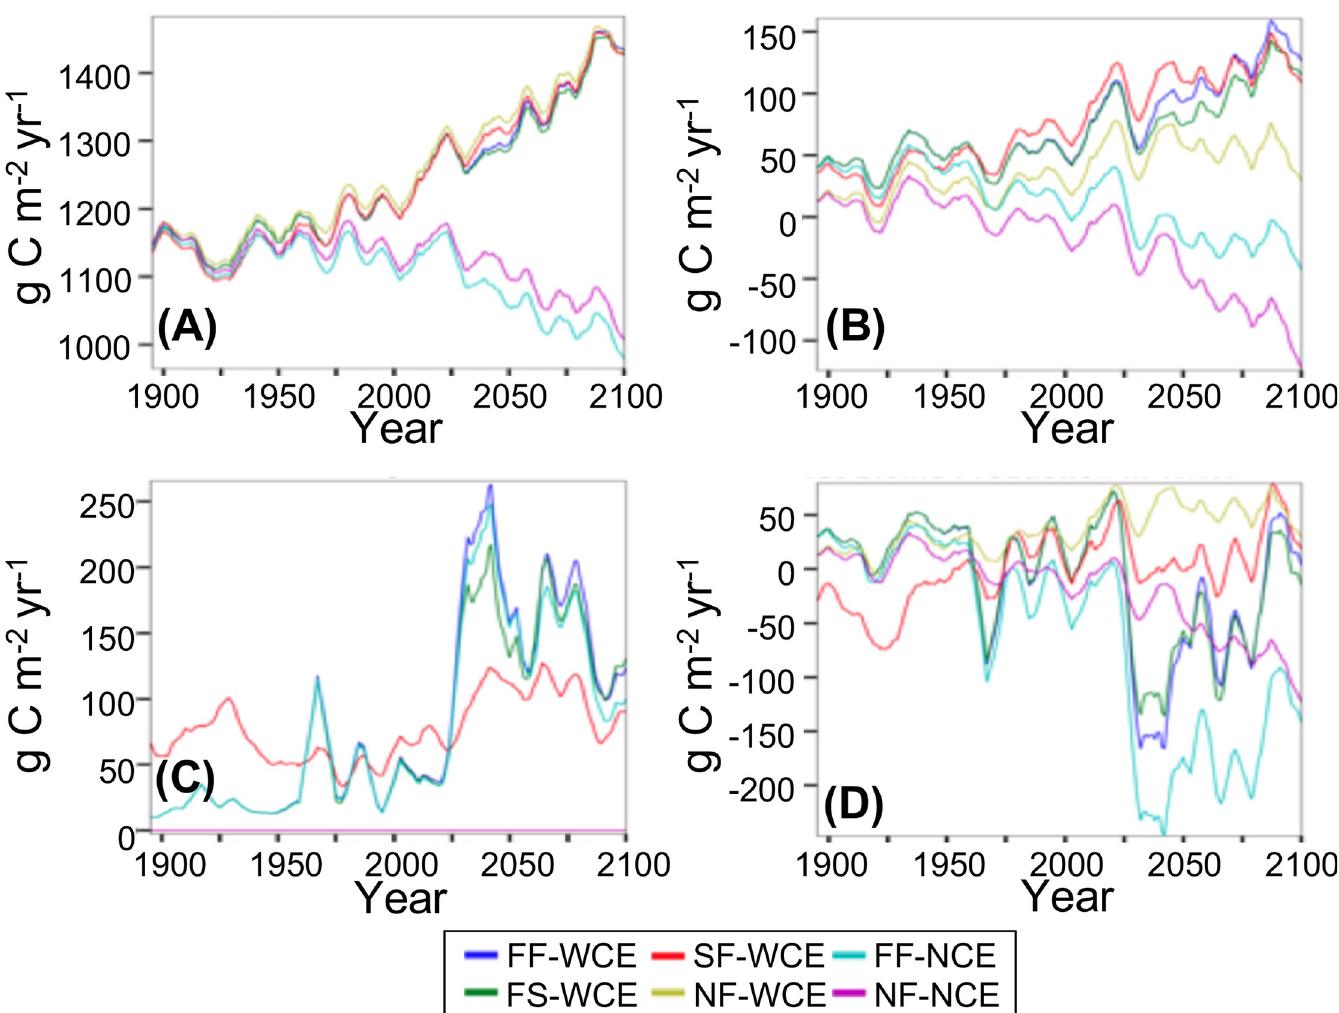
Fig 8. Carbon fluxes simulated by the MC2 vegetation model. (A) NPP (net primary production), (B) NEP (net ecosystem production), (C) C consumed by fire, and (D) NBP (net biome production). (FF-WCE: full fire, with CO 2 fertilization effect; FS-WCE: with fire suppression, with CO 2 fertilization effect; SF-WCE: with stochastic ignitions, with CO 2 fertilization effect; NF-WCE: no fire, with CO 2 fertilization effect; FF-NCE: full fire, with no fertilization effect; and NF-NCE: no fire, with no CO 2 fertilization effect. Results smoothed using triangle smoothing +/- 8